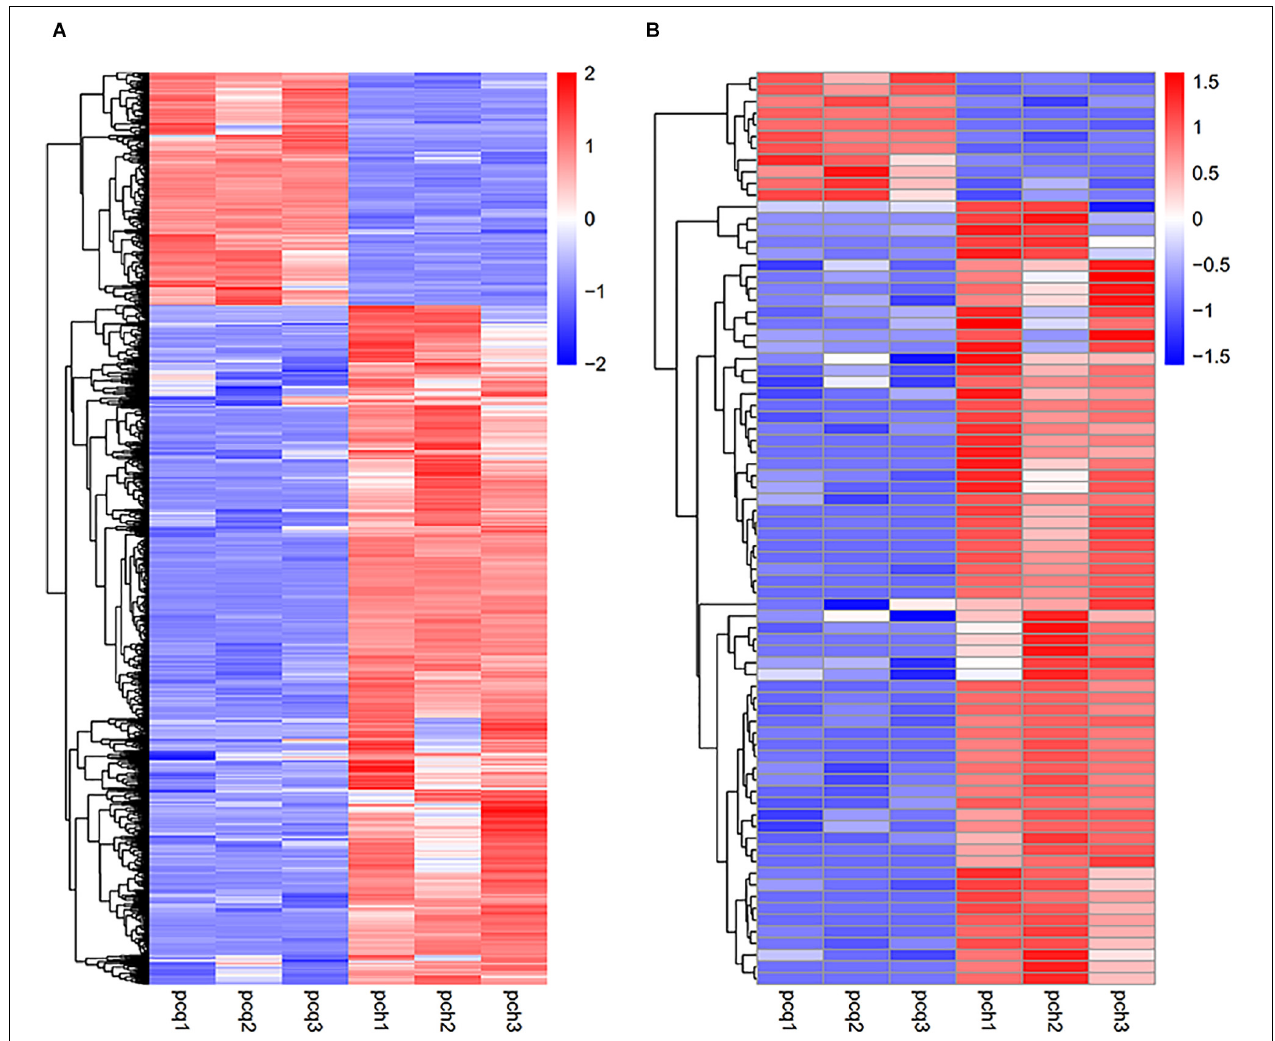
FIGURE 2 | Expression profiles of genes and lncRNAs. Hierarchical clustering of all DEGs (A) and lncRNAs (B) in the P. canadensis pcq and pch